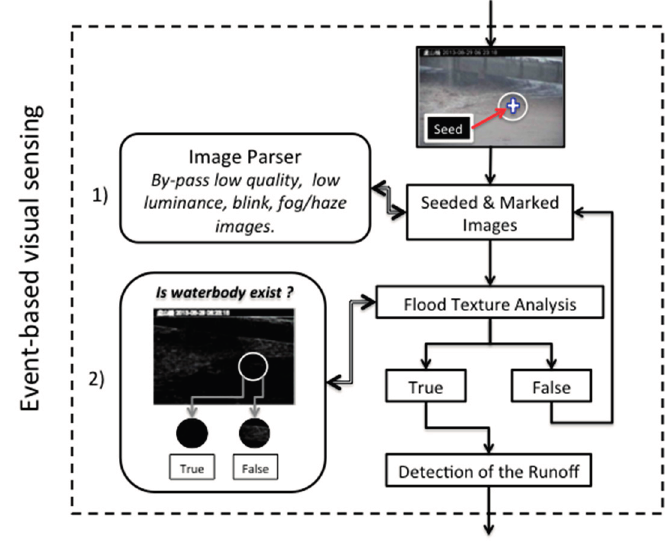
Figure 3. Flowchart of sensing triggered by using event-based rules. All remote monitoring images are subject to a two-stage screening: (1) quality analysis of images for screening of images that cannot be analyzed, and (2) surface texture analysis of the seeding region of interest (ROI) to verify the existence of a waterbody. Only images that are subject to the two-stage screening are used for the subsequent waterbody region